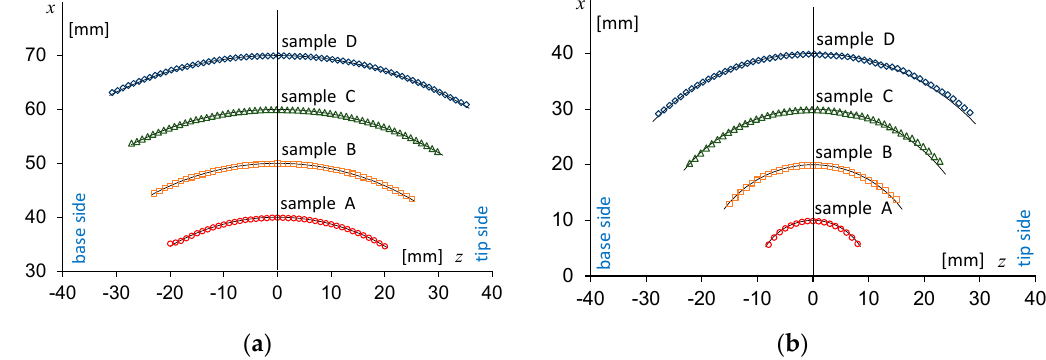
Figure 8. Profiles of the curved portion of samples A, B, C, and D. ( a ) Outer and ( b ) inner sides of the curve. The thin solid lines correspond to target shapes. The horizontal axis represents the axial distance from the middle cross section perpendicular to the spindle axis, in which the base side is negative and the tip side is positive. The origin (0,0) is at the center of each target curvature.